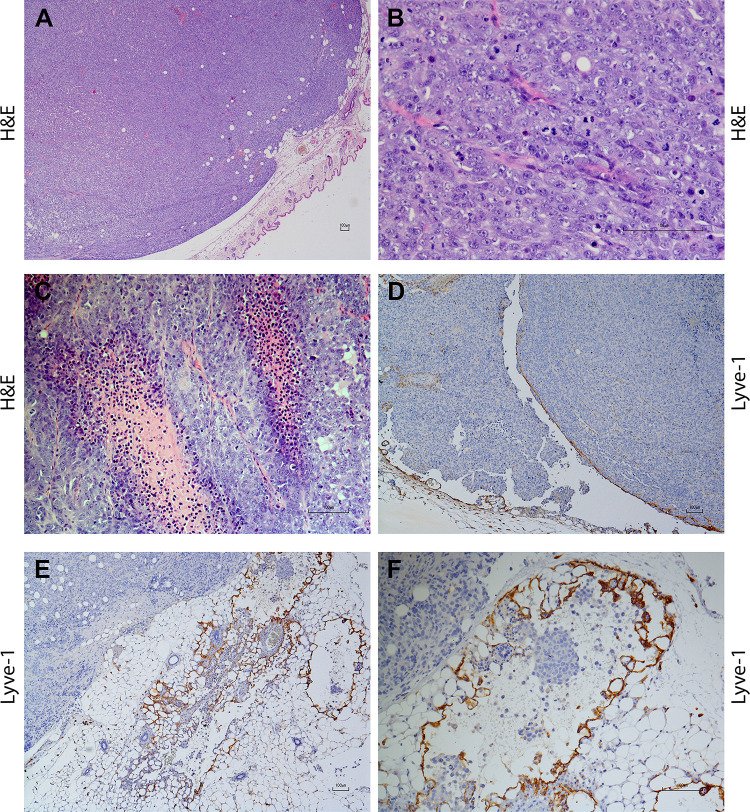
Overview of the histological (A to C) and immunohistochemical (D to F) findings of the HEK-EBNA293-VEGF-D cells xenotransplanted in SCID mice. A: Well-defined, partially encapsulated neoplastic sub-cutaneous mass showing locally expansive growth and densely populated by epithelial cells arranged in chords and supported by a moderate fibrovascular stroma (2x, H&E); B: polygonal cells with a moderate to high nuclear-cytoplasmic ratio. Round to oval nuclei with vesicular chromatin, and evident nucleoli, round and 1–2 in number, basophilic, and paracentrally located. In this field, high mitotic rate and scattered apoptotic figures are observed among neoplastic cells (40x, Haematoxilyn-Eosin, H&E); C, Multifocal intratumoral infiltrates composed by moderate number of neutrophils and fewer lymphocytes embedded in a pale eosinophilic, fibrillar, material (necrosis, 20x, Haematoxilyn-Eosin, H&E). D, E, F: Lyve-1 immunolabeled lymphatic endothelial cells (4x, 10x, 20x) localized in peripheral areas of the tumor among neoplastic cells; F: Neoplastic emboli were frequently found within Lyve-1 immunolabeled lymphatic vessels (40x).